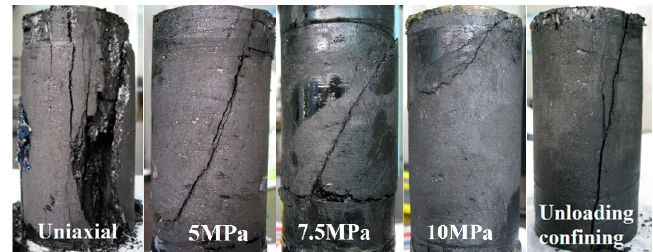
Figure 6. The main crack formation of weak liability coal under different stress conditions.